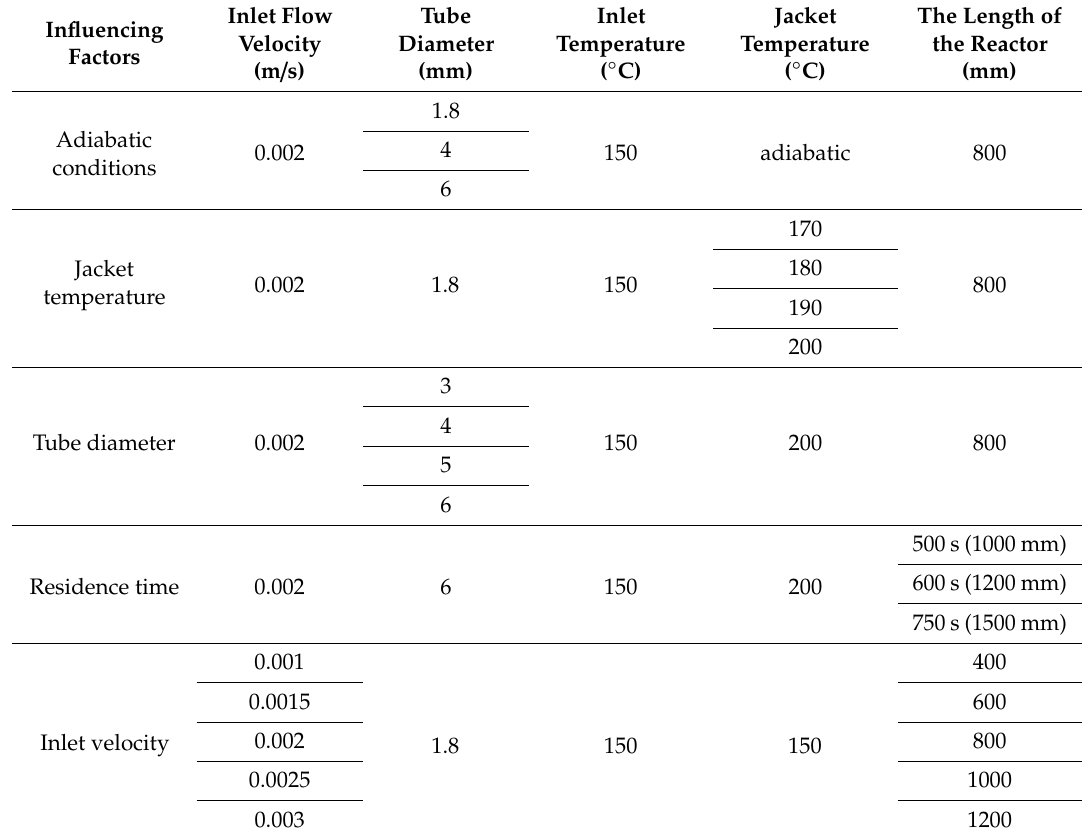
Table 5. Summary of simulation conditions for the thermal polymerization of